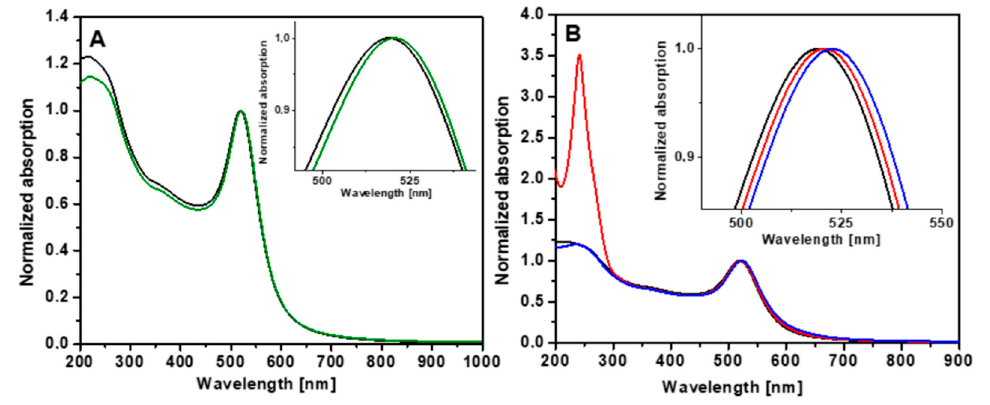
Figure 2. ( A ) Normalized UV-Vis absorption spectra of AuNPs (black) and Plu-AuNPs (green). ( B ) Normalized UV-Vis absorption spectra of AuNPs (black), Dex-AuNPs (red), and Plu-Dex-AuNPs (blue). The inserts show the magnified spectral region of the absorption maxima.